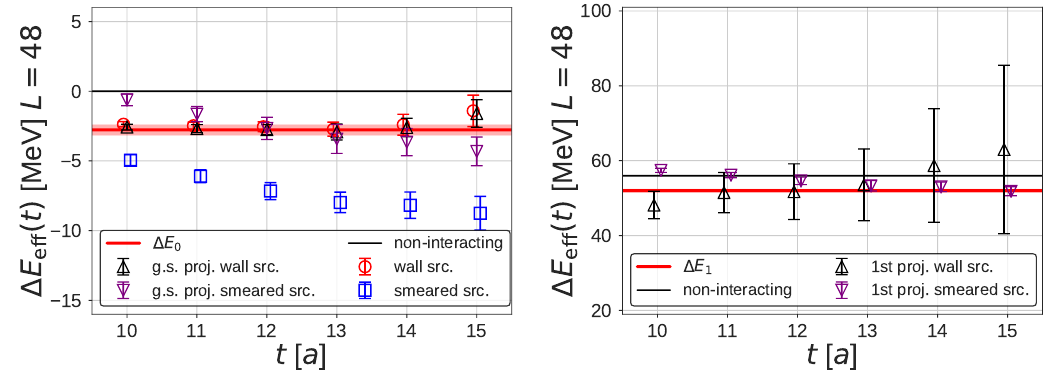
Figure 12 . The e(cid:11)ective energy shift (cid:1) E ( n ) ( t ) on L = 48 from the wall source (black up triangles) e(cid:11) and the smeared source (purple down triangles) for the ground state (left) and the (cid:12)rst excited state (right). Red bands represent the energy shifts with statistical errors obtained from the HAL QCD Hamiltonian H LO , while black lines represent those for a non-interacting system. In the left (cid:12)gure, the e(cid:11)ective energy shifts in the direct method for the wall source (red circles) and the smeared source (blue squares) are also